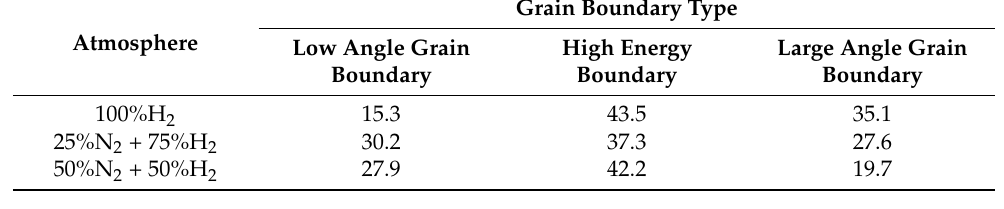
Table 3. Content of main grain boundary (/ %).